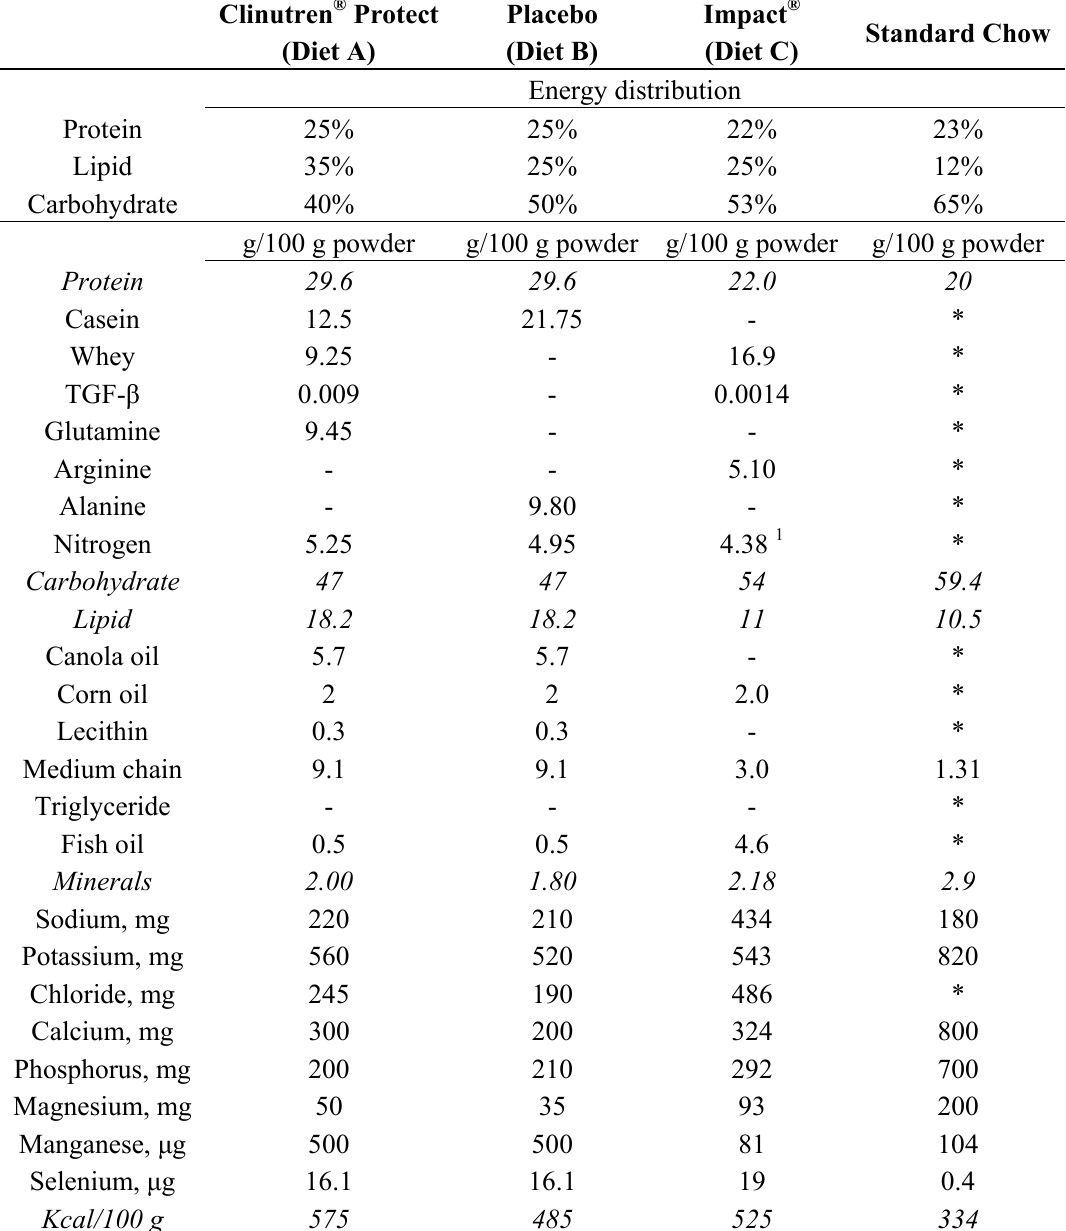
Table 1. Composition of